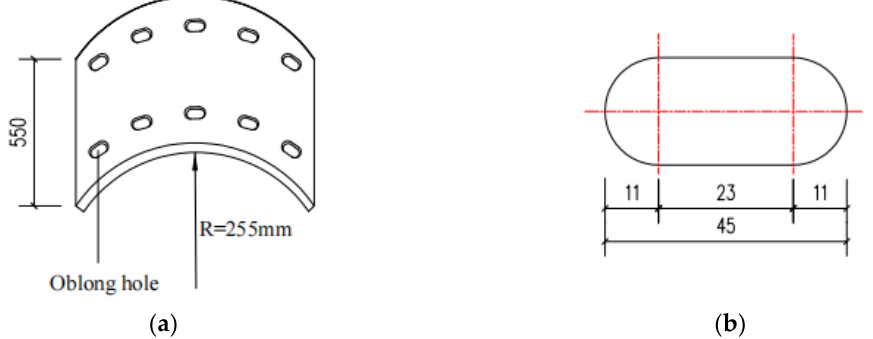
Figure 4. Dimensions of the upper arc end-plate: ( a ) the arc end-plate; ( b ) the oblong bolt holes (unit: mm). Table 1. Parameters of the specimens.